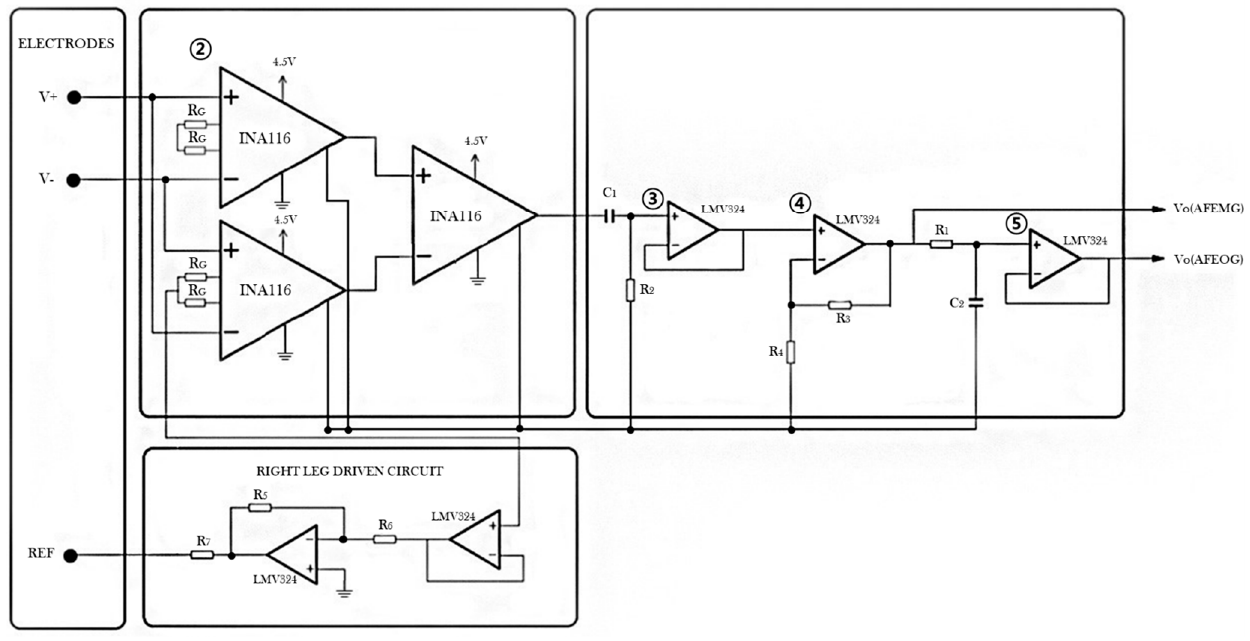
Figure 4. Simplified schematic of the designed circuit for bio-signal